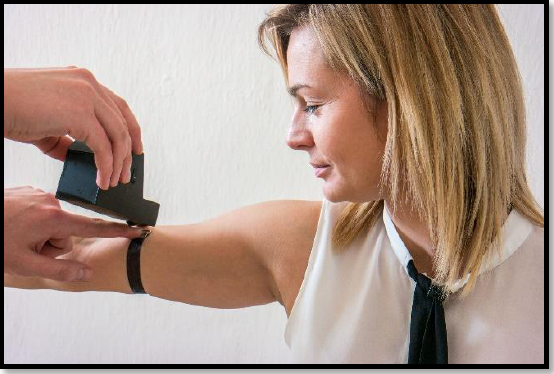
Figure 5. Manual extraction of human